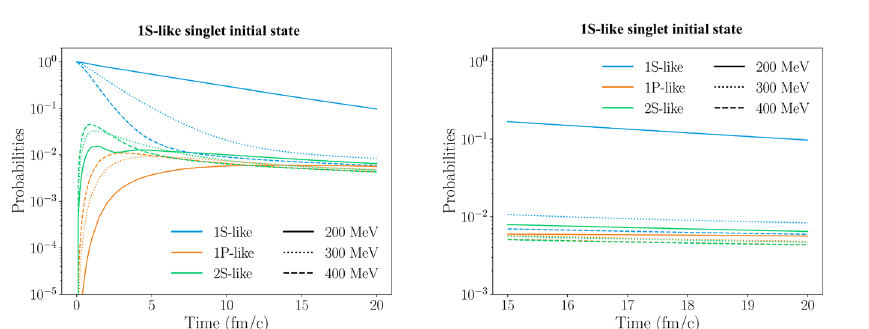
Figure 1. Left panel: Evolution over time of the vacuum eigenstates populations for a temperature T = 200 , 300 and 400 MeV. Right panel: Zoom on the late-time evolution.